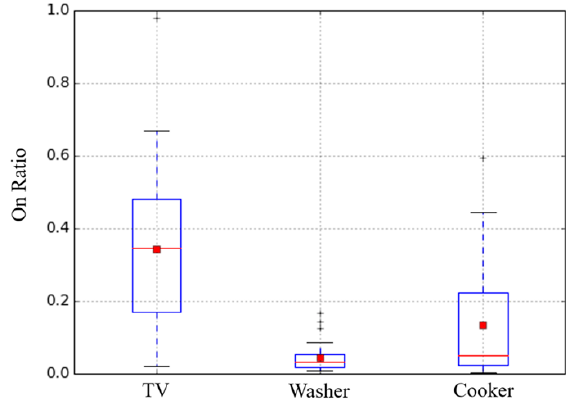
Figure 5. On ratio of appliances in the ENERTALK dataset.